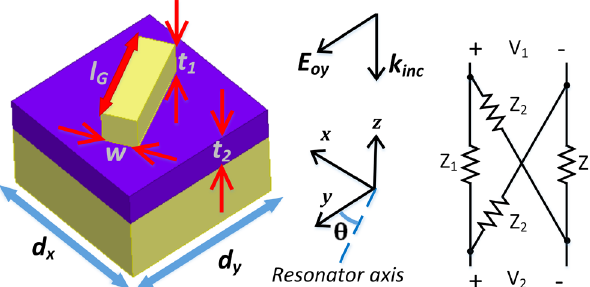
FIG. 3. The schematic of a nanorod GSP resonator unit cell that forms the Huygens ’ metasurface and the proposed equivalent circuit model.